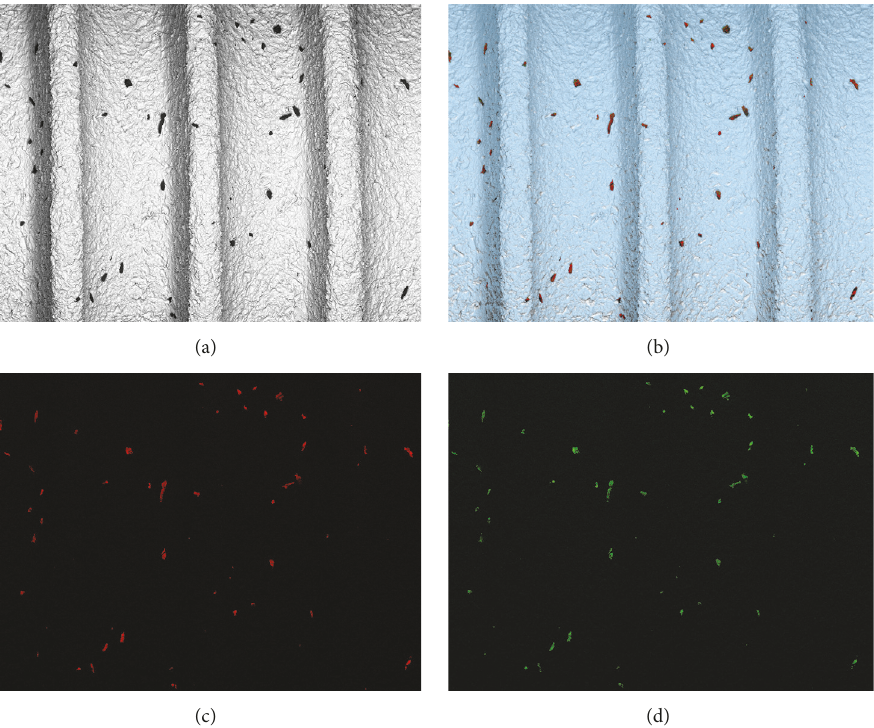
Figure 5: Micrographs of BL Roxolid (cid:2) SLActive (cid:2) implant surface (a), overlay of elements Al and O (b), and mapping of elements Al (c) and O (d).